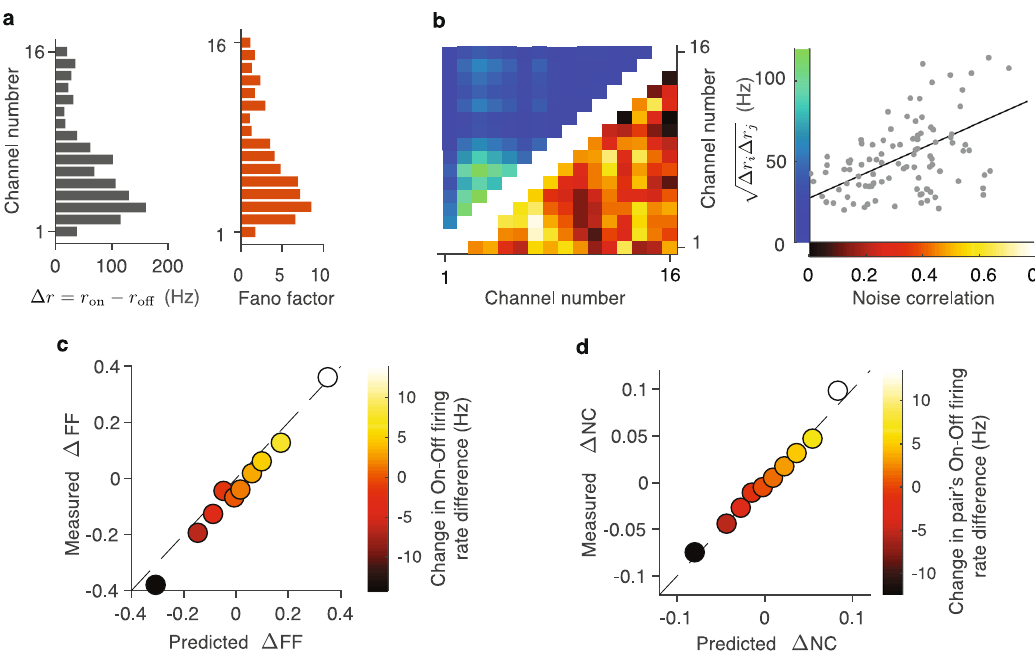
Fig. 3 The model accounts for attentional modulation of correlated variability within columns. a The model predicts that FF is proportional to the On-Off fi ring-rate difference Δ r = r − r Δ r ranges broadly across MUs (gray, left panel), and this variation of Δ r tightly corresponds on off . For an example recording, with the variation of FF (orange, right panel). b The model predicts that noise correlation between neurons i and j is proportional to the product Δ r i Δ r j . For ffiffiffiffiffiffiffiffiffiffiffiffi p Δ r Δ r the same example recording, the variation in corresponds with the variation of noise correlations (left). Noise correlations are positively correlated i j ffiffiffiffiffiffiffiffiffiffiffiffi p Δ r Δ r with , (right, black line - linear regression). c Comparison between attention-related changes ( Δ FF = FF att − FF ctl ) in FF predicted by the On-Off i j dynamics model ( x -axis) and measured directly from the data ( y -axis) for MUs. All MUs are divided into 10 equally-sized groups based on the change in their On-Off fi ring-rate difference between attention and control conditions ( Δ r att − Δ r ctl , color axis). d Comparison between attention-related changes ( Δ NC = NC att − NC ctl ) in noise correlations (NC) predicted by the On-Off dynamics model ( x -axis) and measured directly from the data ( y -axis) for MUs. All MU-pairs are divided in 10 equally sized groups based on the change in the pair ’ s On-Off fi ring-rate difference de fi ned as (color axis). Source data are provided as a Source Data fi